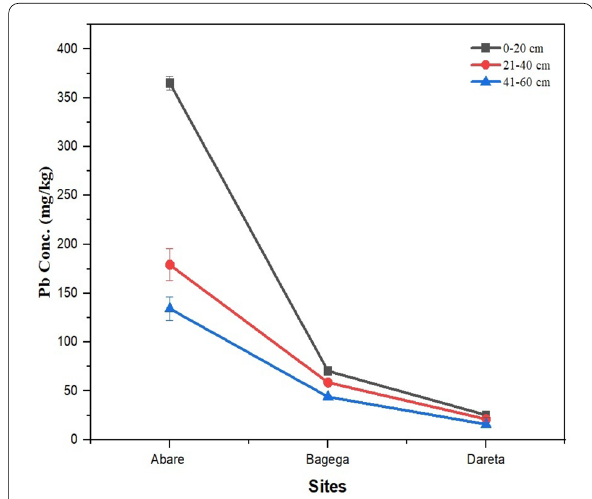
Fig.2 Pattern of lead (Pb) concentration (mg/kg) across the three (3) soil depths in the cultivated farmland of Abare, Bagega and Dareta